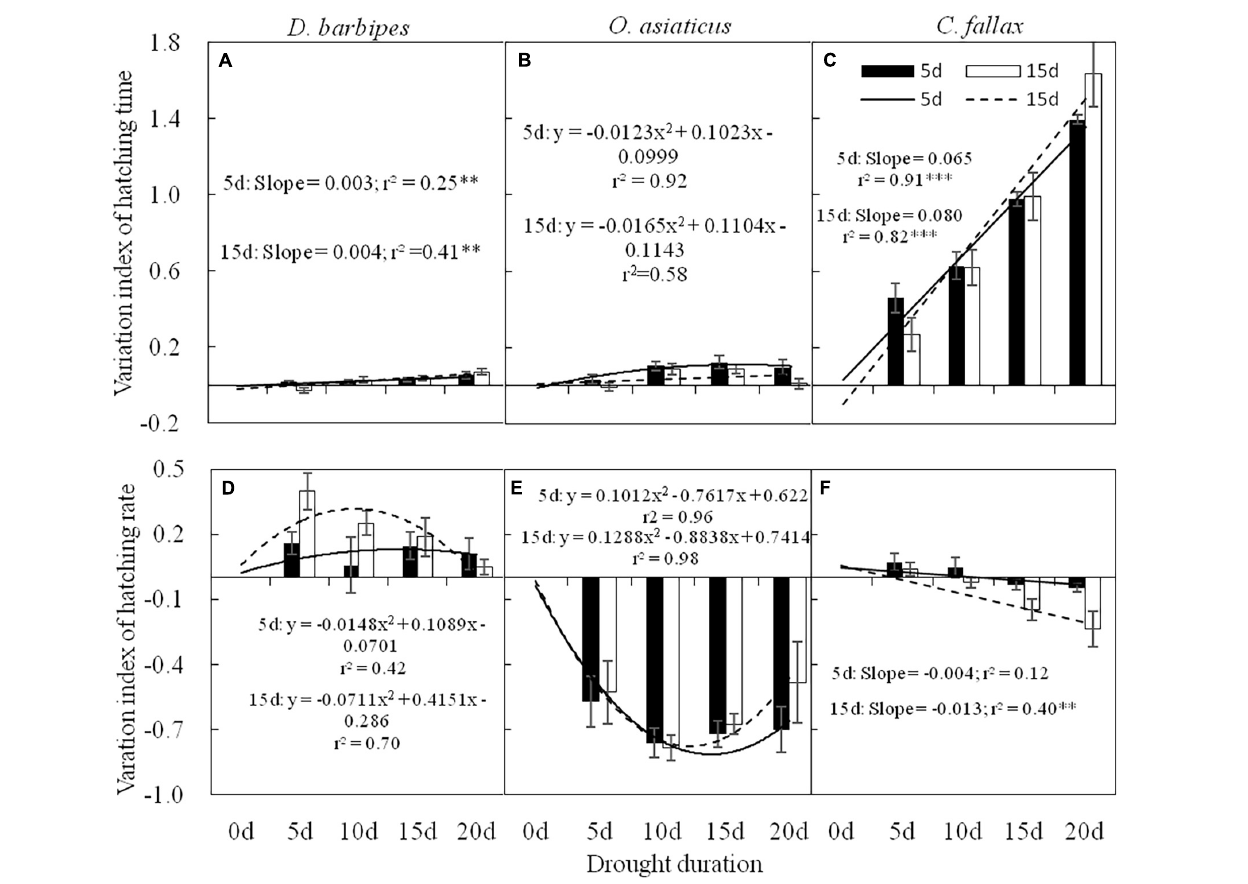
FIGURE 3 | Variation index (VI) of hatching time (A,B,C) and hatching rate (D,E,F) of eggs of D. barbipes, O. asiaticus and C. fallax predeveloping for 5 and 15 days under different drought durations. VI = (treatment-control)/control. VI > 0 indicate an increase in the treatment compared with the control; VI = 0, means no change in the treatment compared with the control; and < 0, indicates a decrease in the treatment compared with the control. Regression parameters were estimated using linear models with drought duration as a continuous predictor. Significant linear regressions are indicated by ∗ ( P < 0.05), ∗∗ ( P < 0.01), and ∗∗∗ ( P < 0.001). Data are mean ± SE ( n =